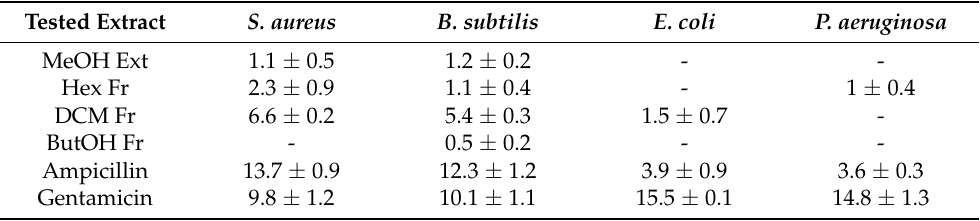
Table 3. Inhibition zone diameter (mm) of the methanol extract and fractions of C. siphonella on S. aureus , B. subtilis , E. coli and P. aeruginosa (Mean ± S.E). Tested Extract S. aureus B. subtilis E. coli P. aeruginosa MeOH Ext 1.1 ± 0.5